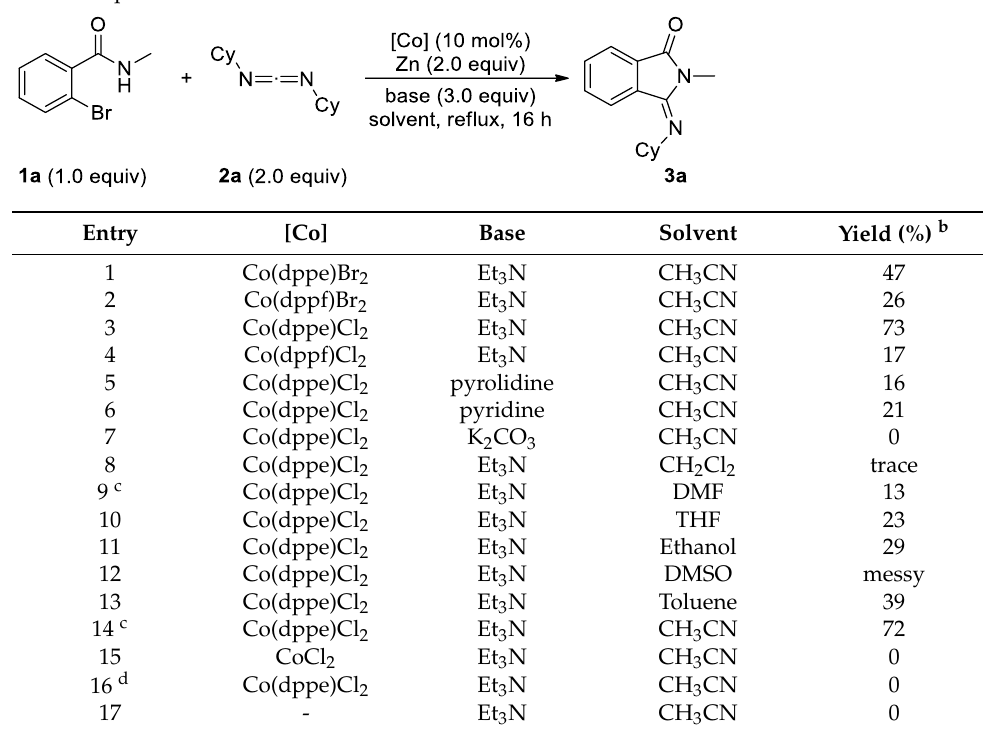
Table 1. Optimization of reaction conditions a,b .